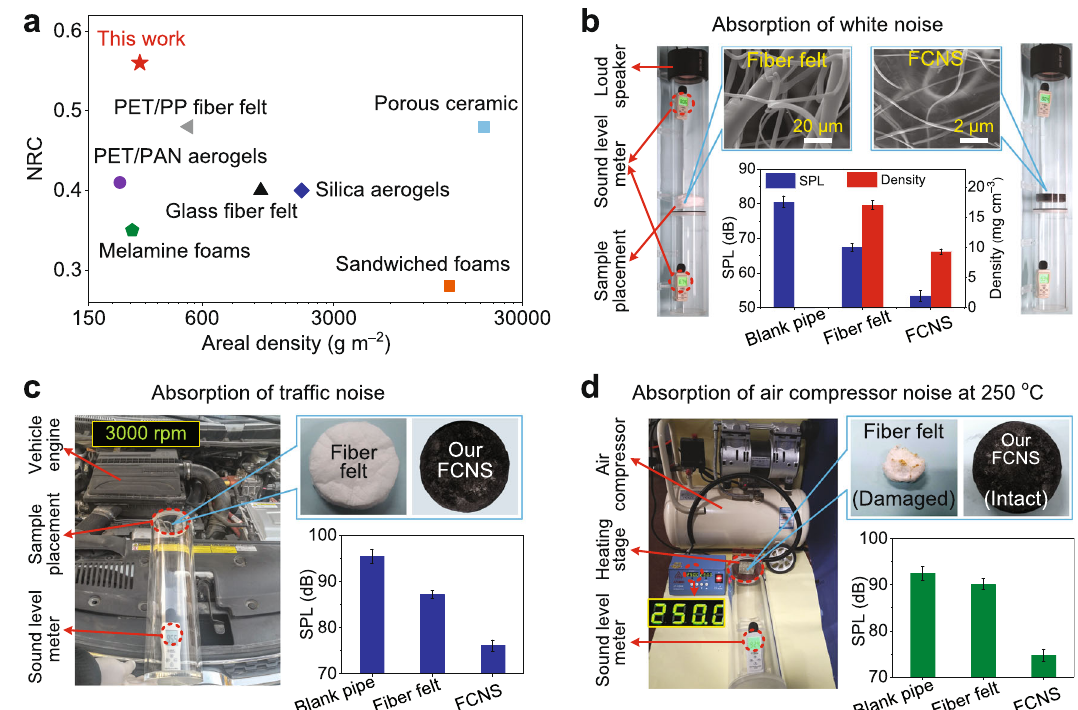
Fig. 6 Application performances of sandwiched FCNSs. a Comparison of NRC for the different noise reduction materials and the sandwiched FCNSs. Photographs showing the direct application of the commercial fi ber felt and sandwiched FCNSs on the b white noise absorption, c automobile engine noise absorption at 3000 rpm, and d air compressor noise absorption at the high temperature of 250 °C. Error bars in b – d represent the standard deviations of three